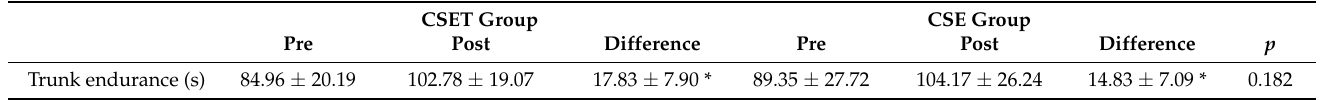
Table 3. Subject scores of trunk endurance before and after intervention.